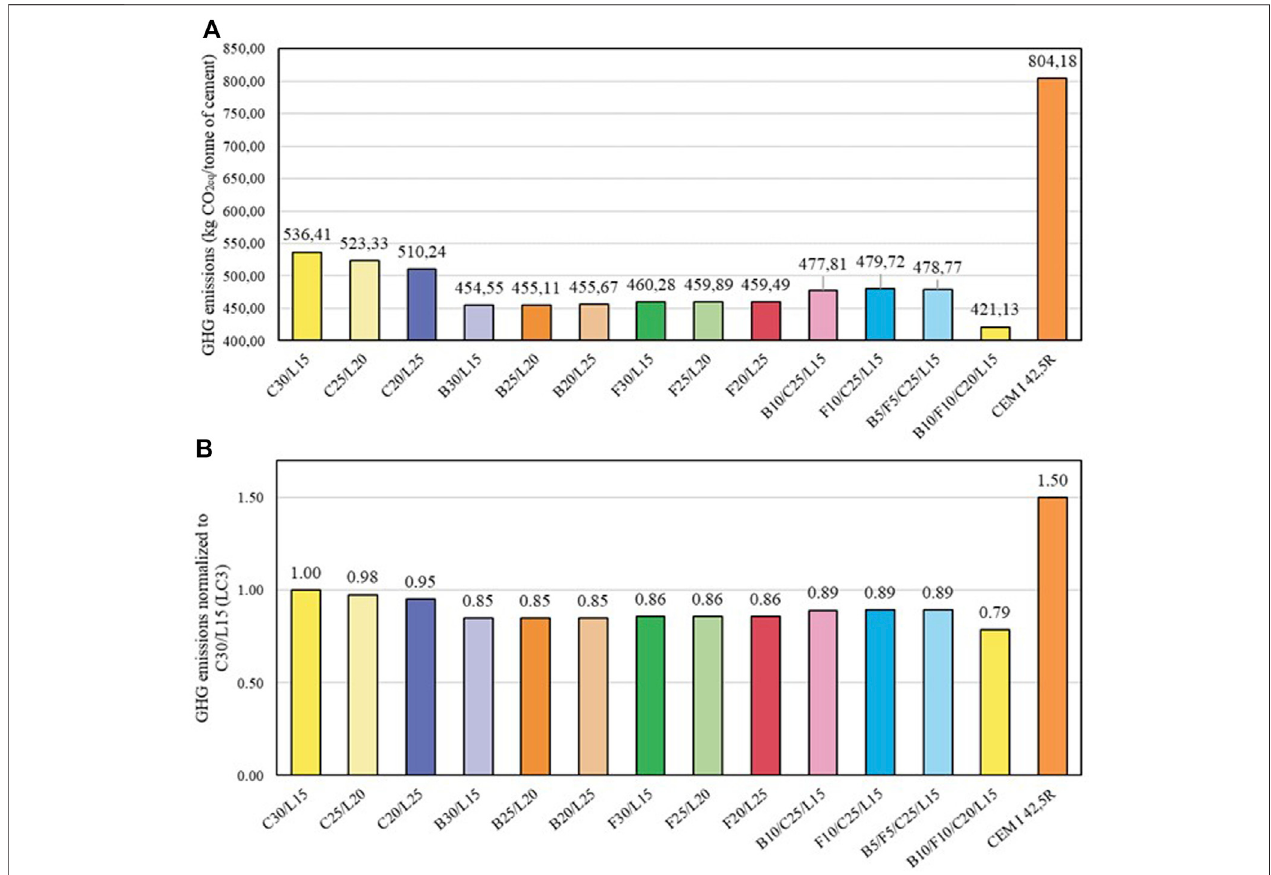
FIGURE 5 | (A) cements ’ GHG emissons (in CO 2eq ); (B) GHG emissions normalized relative to GHG emissions of C30/L15 (LC 3